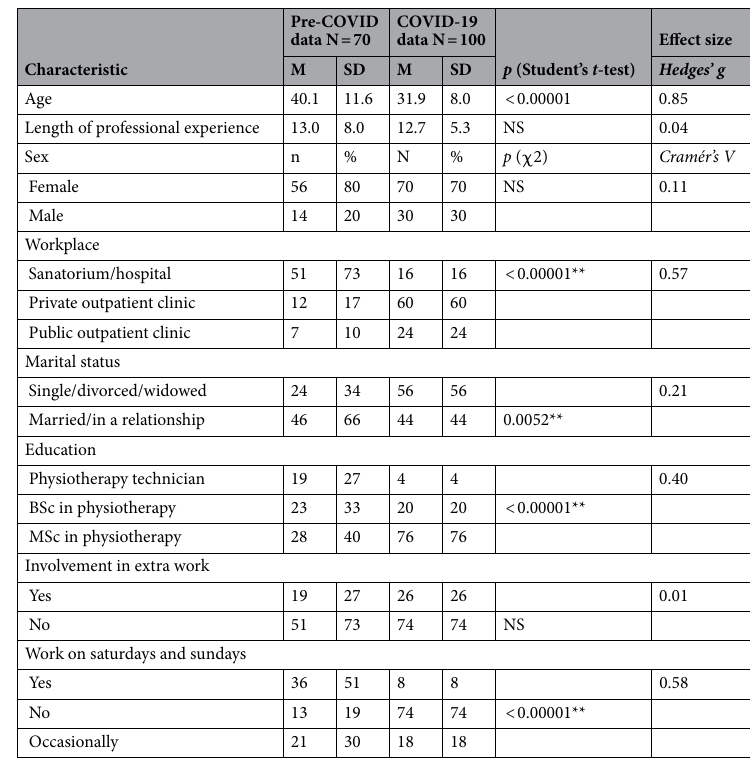
Table 1. Characteristics of two study groups (Student’s t -test and χ 2 test). BSc Bachelor’s degree